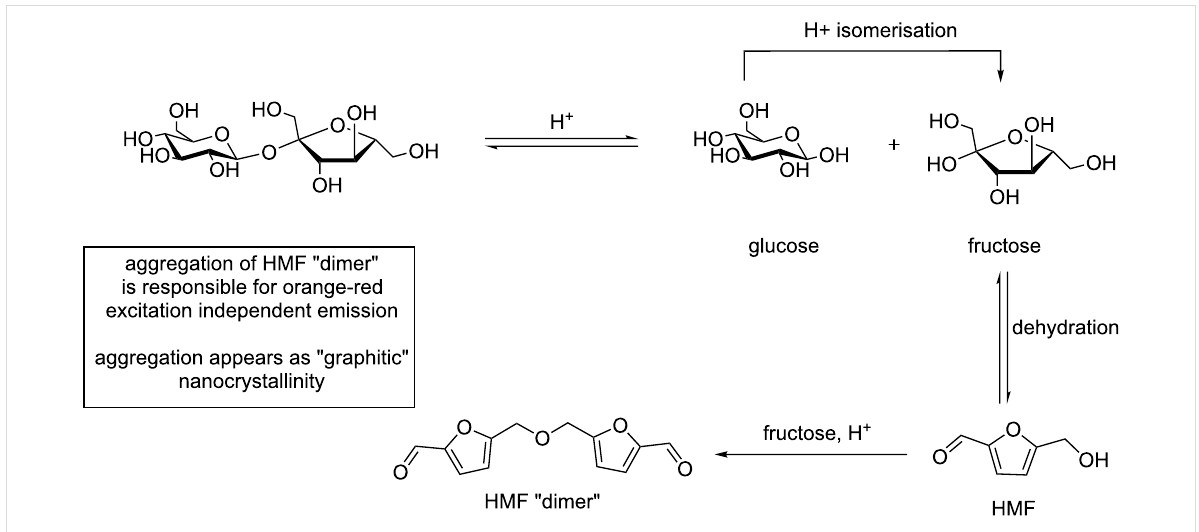
Scheme 19: Proposed HMF dimer, and its formation mechanism, that upon aggregations bestows orange-red emissive on sucrose-derived